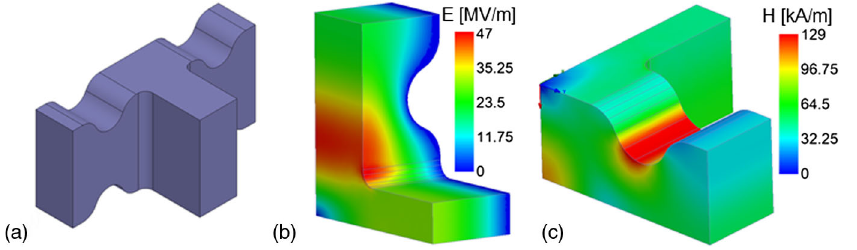
FIG. 5. E-plane splitter for feeding the waveguide coupler of the deflector, fields normalized to 100 MWof transmitted power: (a) solid model of the splitter ’ s rf volume; (b) surface electric fields with maximum value of 47 MV = m; (c) surface magnetic fields with maximum value of 129 kA = m.